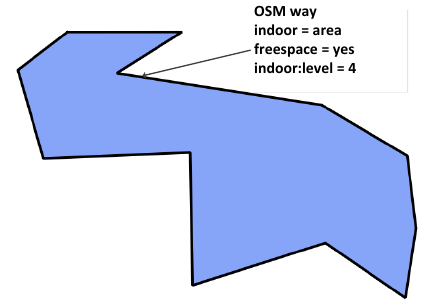
Figure 4. An area with a complex